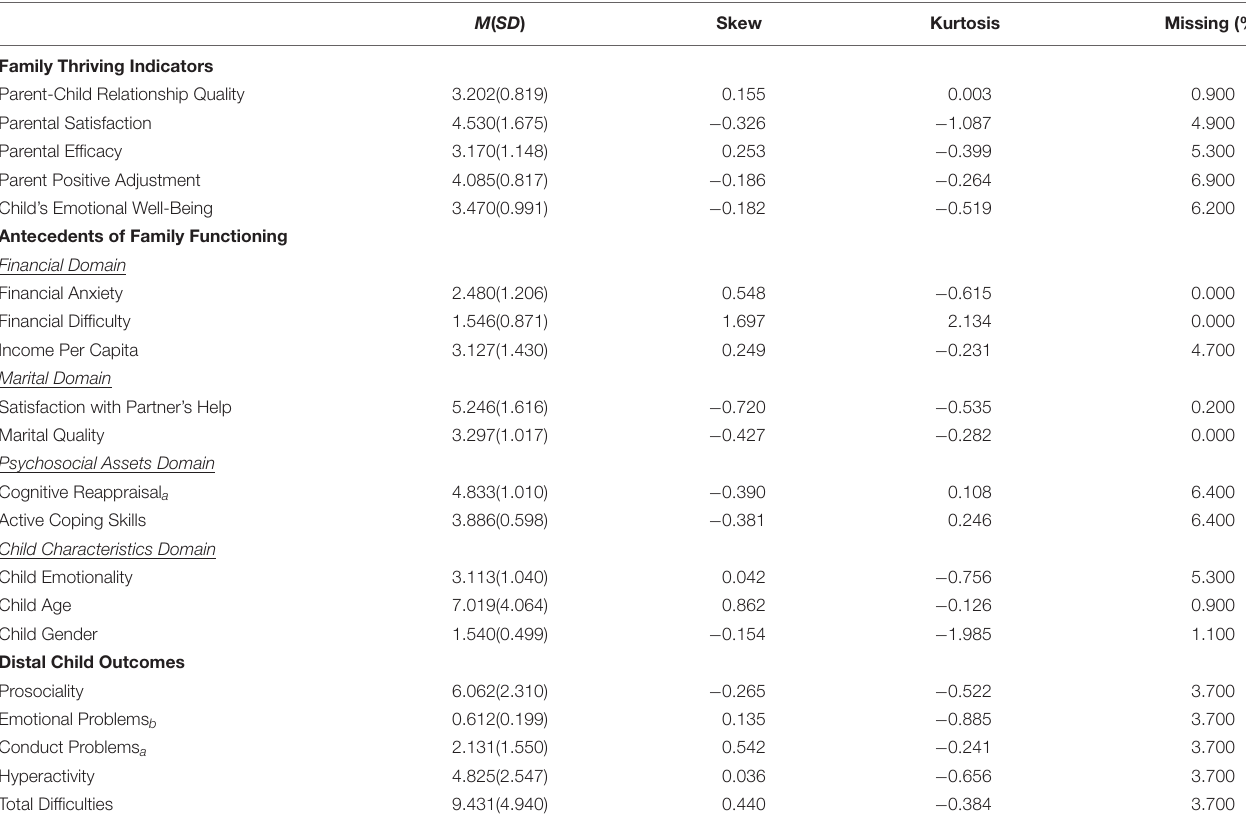
TABLE 1 | Descriptive statistics for key study variables.